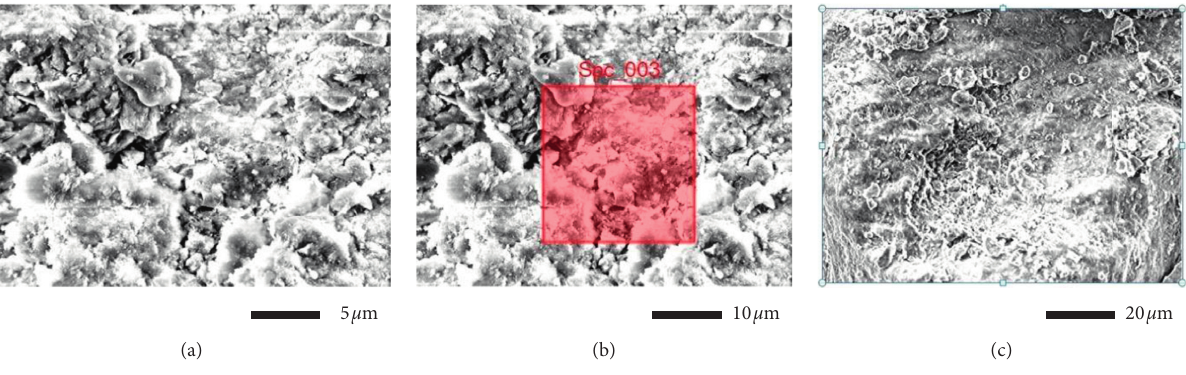
Figure 3: SEM images of the salt